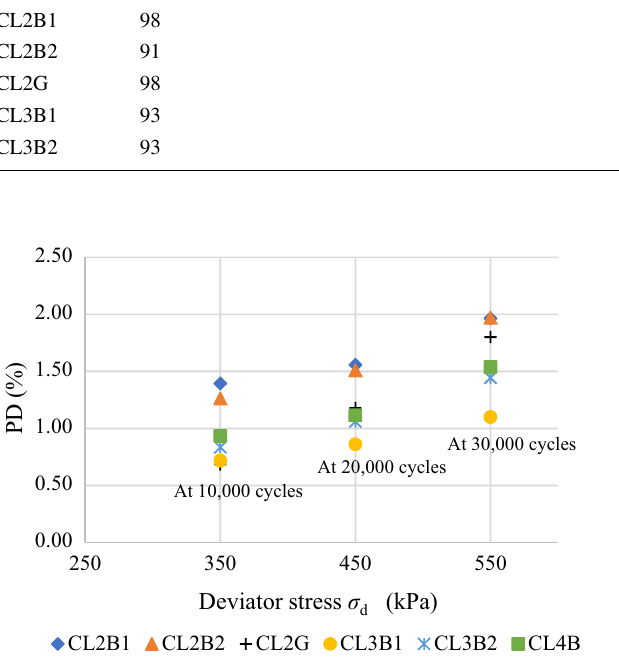
Fig. 8 Effect of deviator stress on PD of UGMs (at OMC and